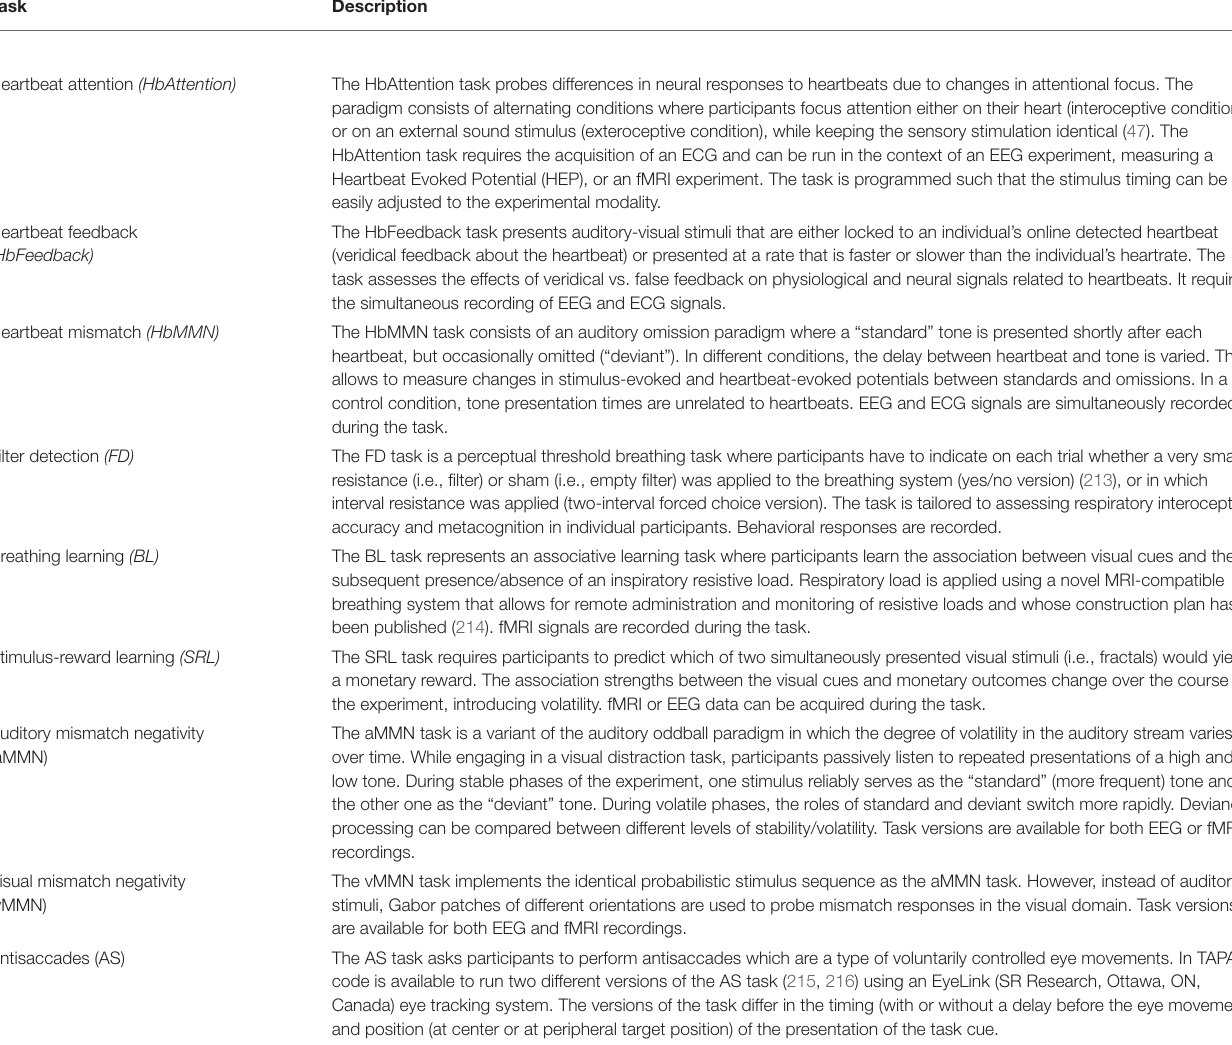
TABLE 1 | List of tasks (to be) included in TAPAS Tasks.